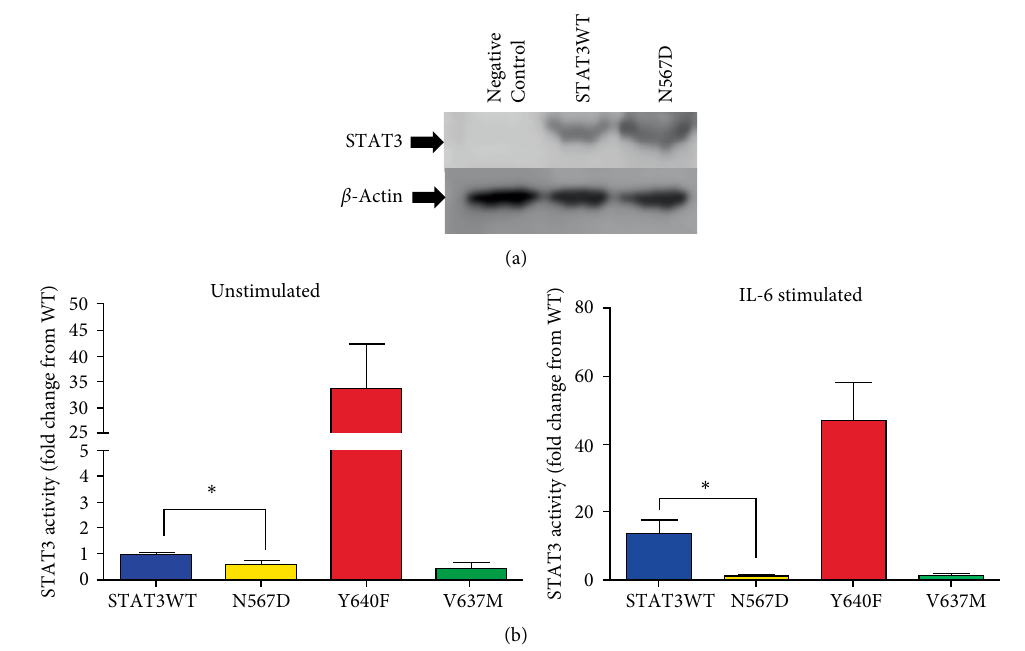
Figure 2: Transfection of N567D-STAT3 into cells increased STAT3 activity. (a) HEK293 cells were transfected with equal amounts of an empty vector, wildtype STAT3 or N567D and expression of STAT3 was studied by Western blotting. Results are representative of two independent experiments. (b) Cells were alternatively transfected with wildtype, N567D, and mutations which are known to activate (Y640F), and inactivate (V637M) STAT3. These cells were either grown in the presence or absence of 20 ng/ml IL-6 for 18 h, and transcriptional activity was determined using a dual-luciferase reporter assay ( 𝑛 = 3 − 6 ). ∗ 𝑃 < 0.05